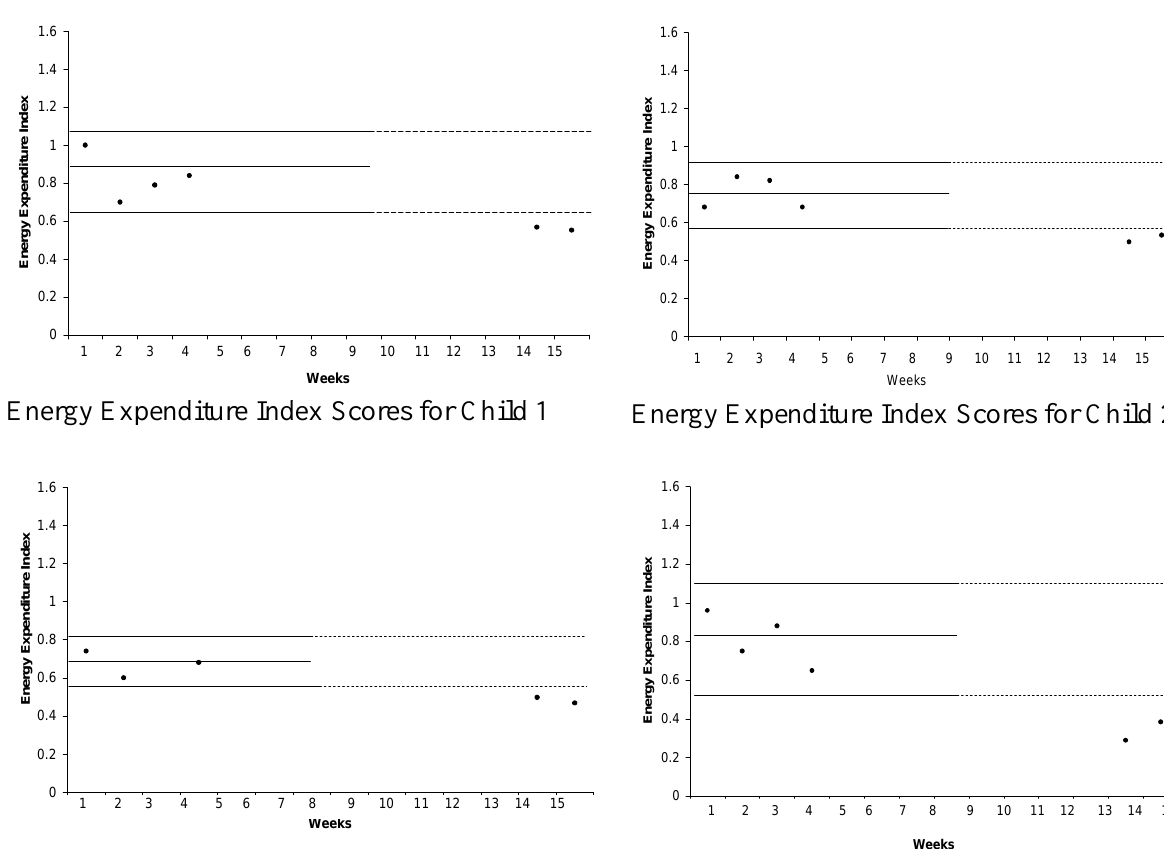
Figure 1. Energy Expenditure Index Scores for Child 1 through